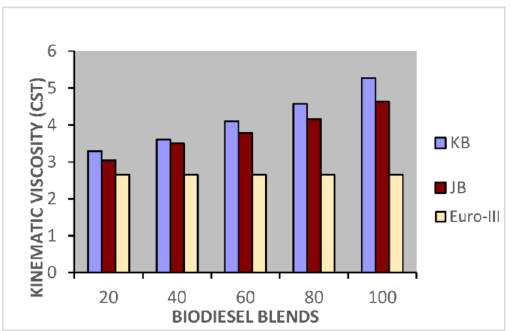
Figure 2. Variation of kinematics viscosity of Jatropha curcus and Pongamia pinnata methyl esters blends with EURO-III HSD.